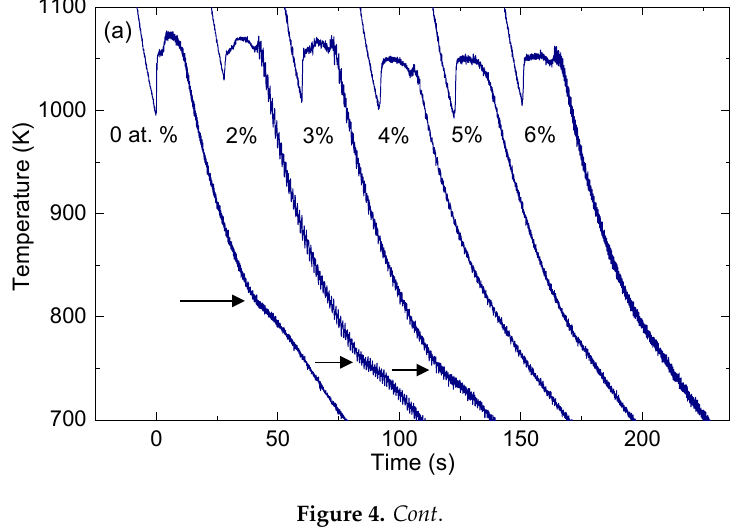
Figure 4. ( a ) Temperature-time profiles of (Ti 35.2 Zr 43.8 Ni 21 ) 100 − x Ag x alloy liquids in the ESL experiment. ( b ) XRD patterns of (Ti 35.2 Zr 43.8 Ni 21 ) 100 − x Ag x alloys processed by ESL. The i -phase, C 14 Laves, and α (Ti/Zr) phases were marked by diamonds ( ◆ ), triangles ( ▼ ), and circles ( ● ), respectively. The improved formability of the i -phase is confirmed with XRD measurements of the samples processed in the ESL, as shown in Figure 4b; while no i -phase remains in the sample with no Ag addition, the sample with 4.5 at.% Ag addition still contains i -phase that is about 20% of the volume fraction. More than this concentration, the volume fraction of i -phase decreases again in the samples. Note that the correlation between the stability of the i -phase and Ag concentration is slightly different on cooling (Figure 4) and heating (Figures 2 and 3). This may be due to a different kinetic effect on the phase transformation or a different cooling-rate dependence on the thermal stability of the i - phase, C 14 Laves, and β -phases in Ti 35.2 Zr 43.8 Ni 21 . We reported that upon solidification of the